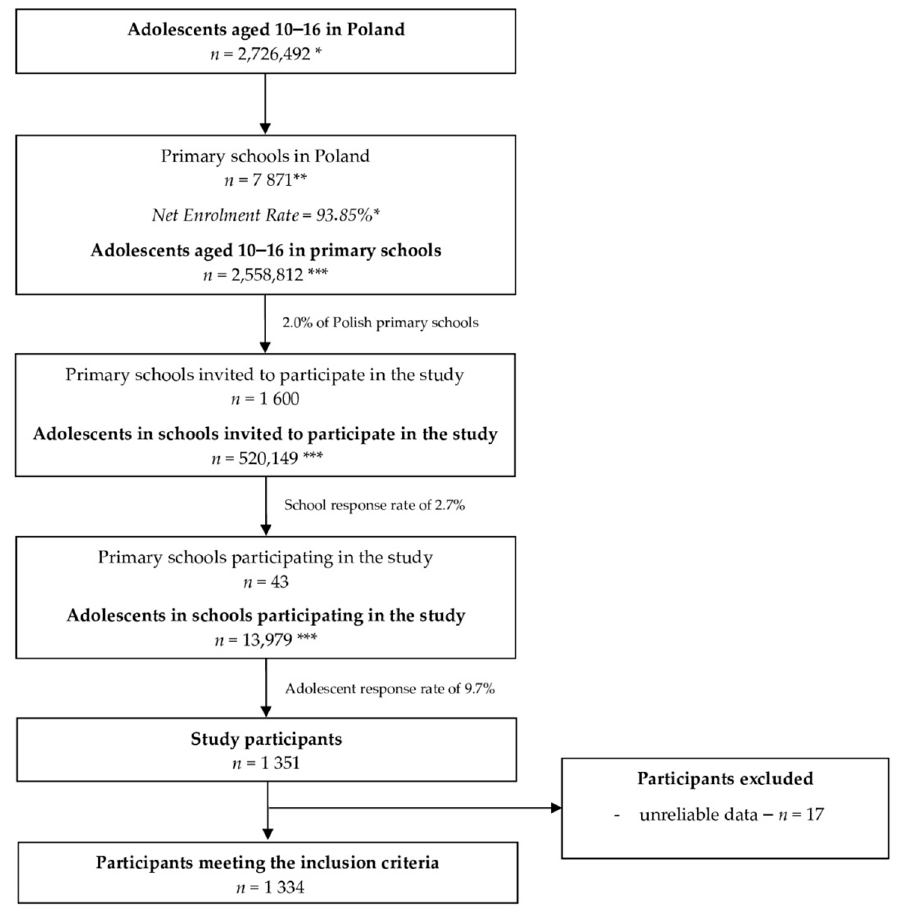
Figure 1. The flow chart of the sampling procedure within the Diet and Activity of Youth during COVID-19 (DAY-19) Study. * data of the Central Statistical Office (CSO) [37,38]; ** data of the Polish Ministry of National Education [39]; *** calculated based on CSO data.